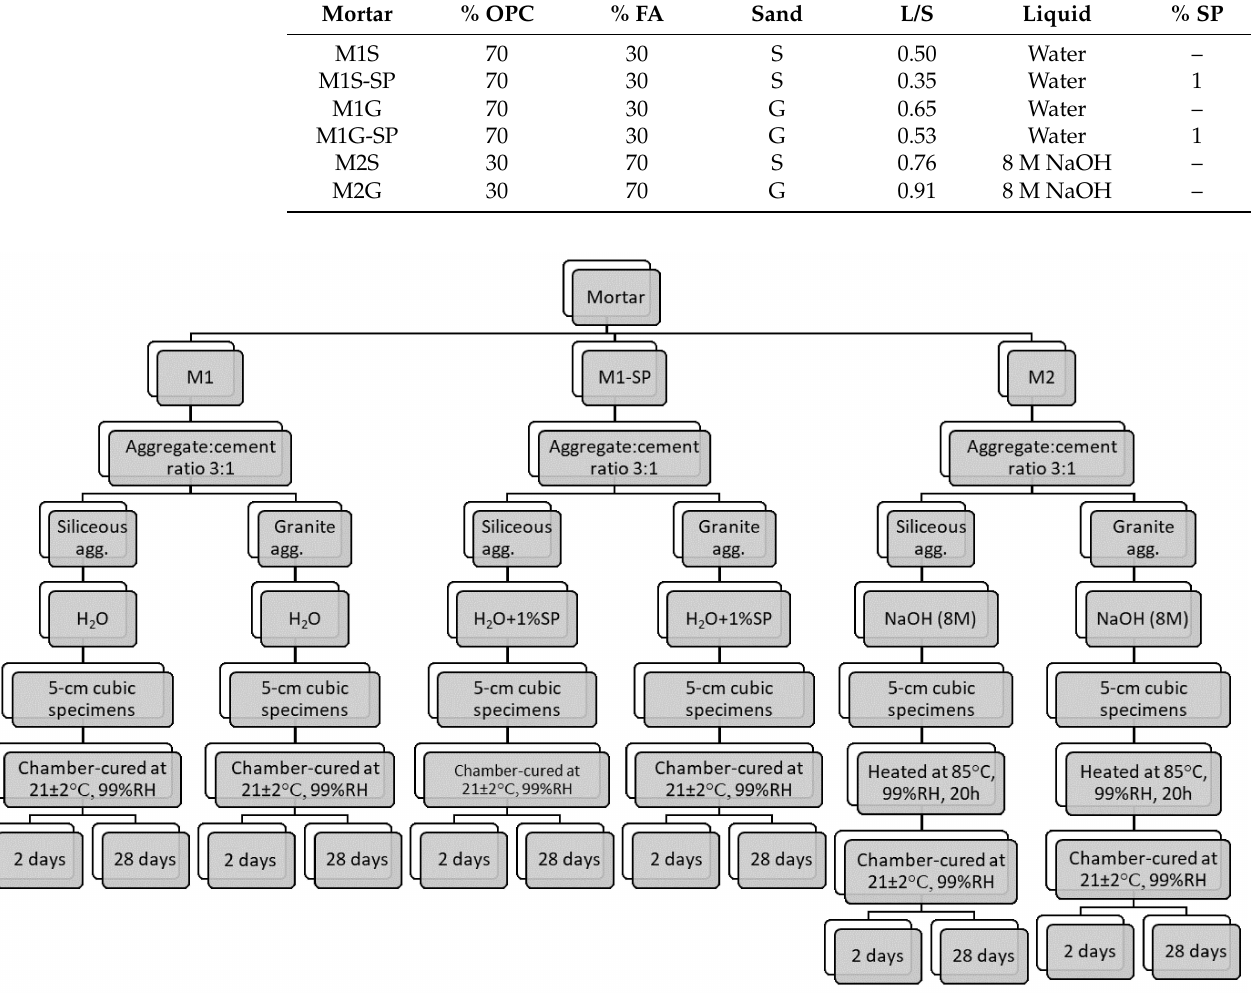
Figure 1. Mortar preparation flow